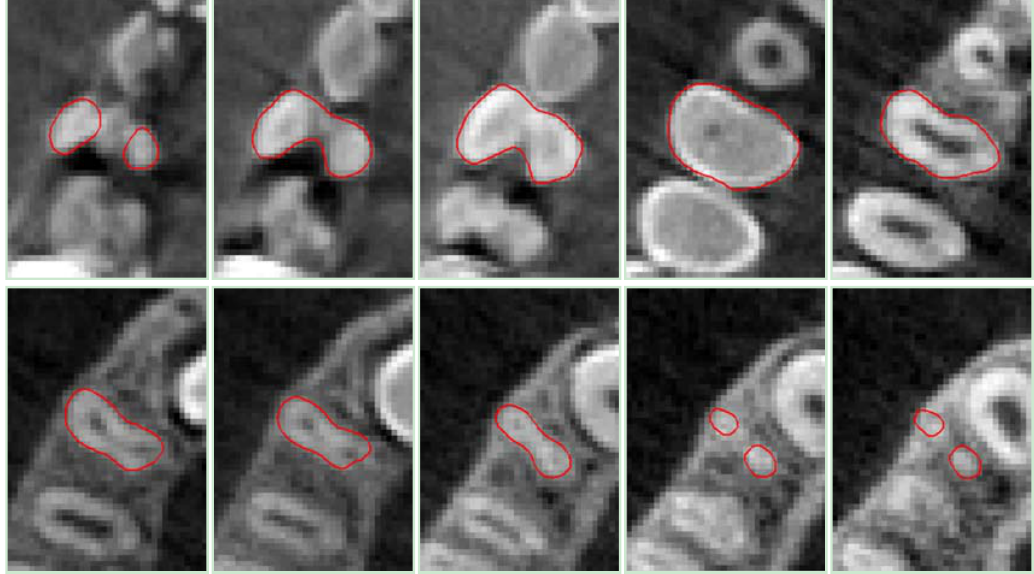
Figure 12. Results of the DRLSE method for tooth 14 , obtained by processing some CBCT slice images.